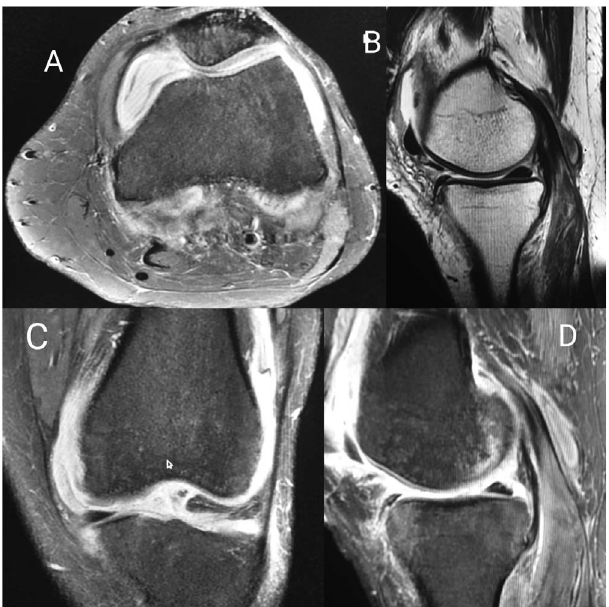
Figure 4. Figure showing MRI sections of a patient with infective pathology (A – coronal STIR, B – sagittal STIR, C – coronal T1, D – sagittal STIR images showing moderate effusion with peripherally enhanced intensities in popliteal fossa).